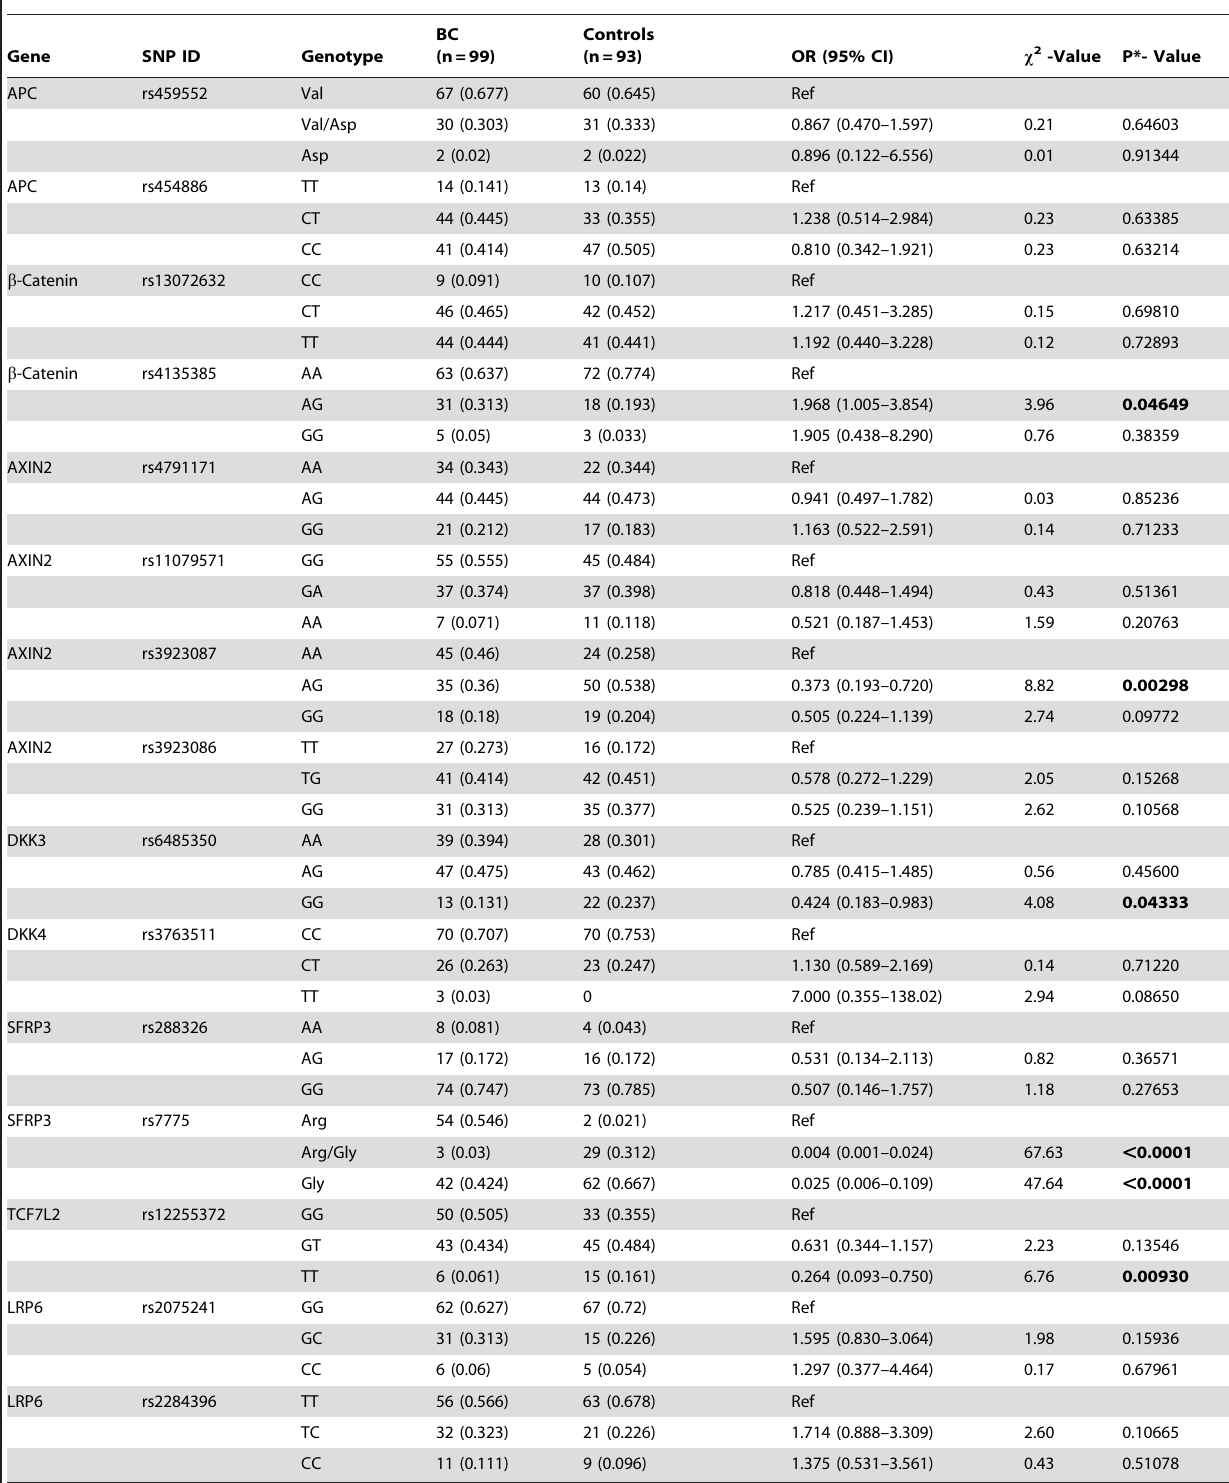
Table 2. Genotype frequencies of Wnt pathway gene polymorphism in breast cancers and